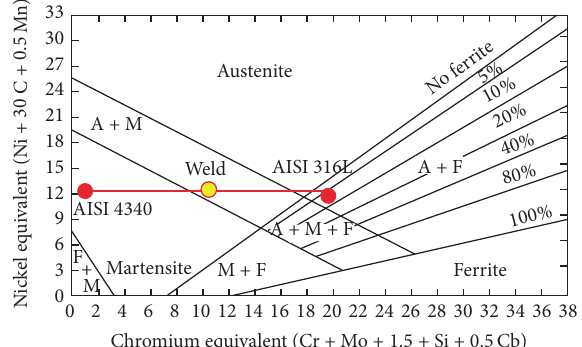
Figure 11: The predicted weld microstructure by Schaeffler diagram